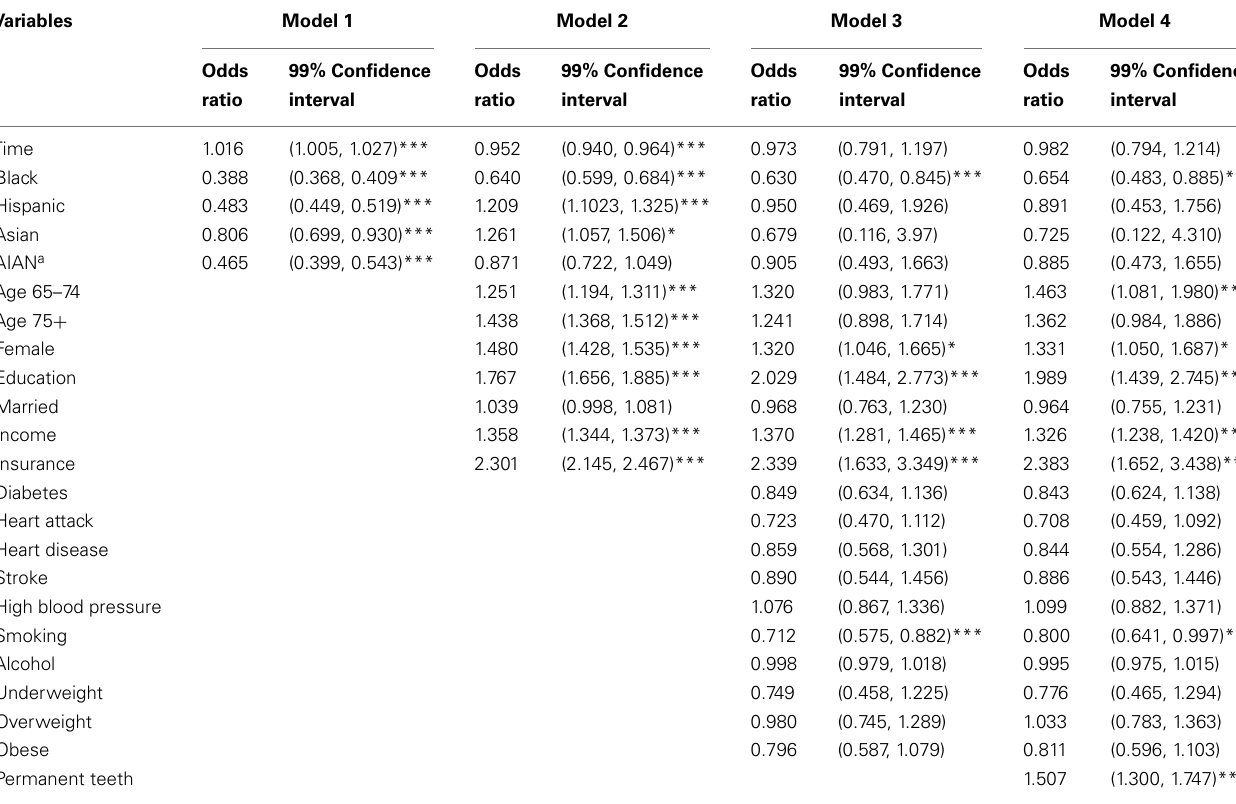
Table 3 | Logistic regression on last dental cleaning